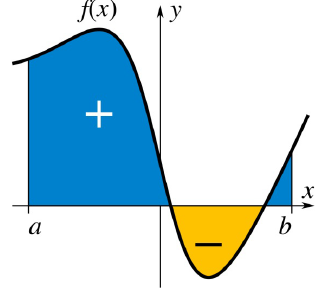
Fig. 1 B-theoretical image